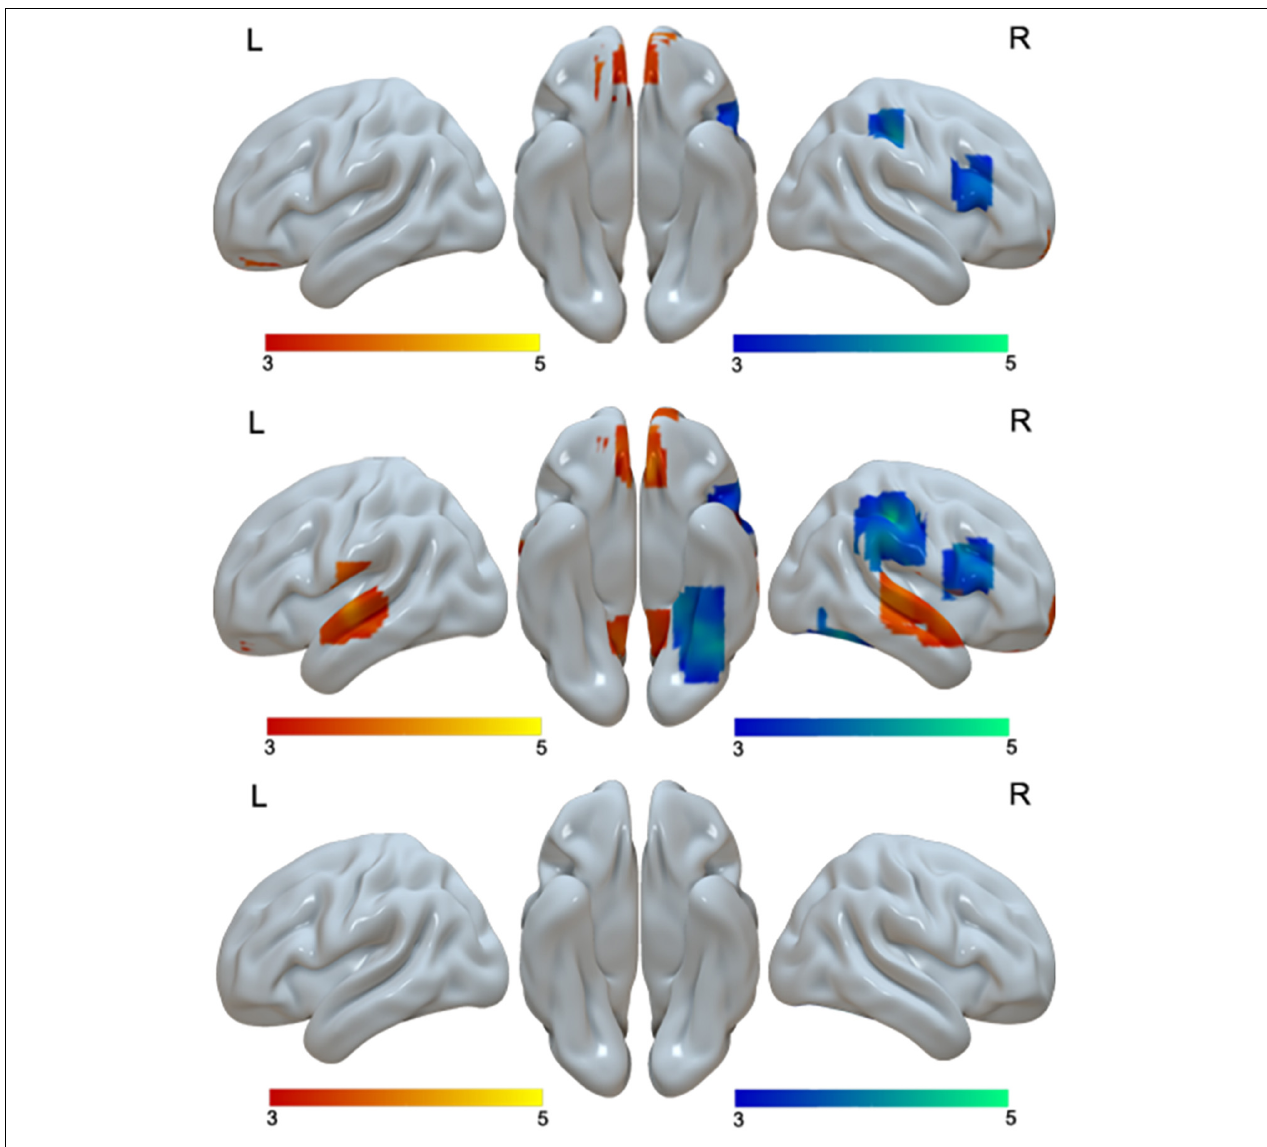
FIGURE 4 | Brain activation in the interaction of language by age (first row), including brain activation in the positive interaction (red), and brain regions in the negative interaction (blue). Brain activation in the comparison between adults and children in English (second row). Brain regions that were more activated in adults than in children in English are in red; brain regions that were more activated in children than in adults are in blue. No brain regions showed age differences in Chinese (third row). The interactions were driven by greater age differences in English than in